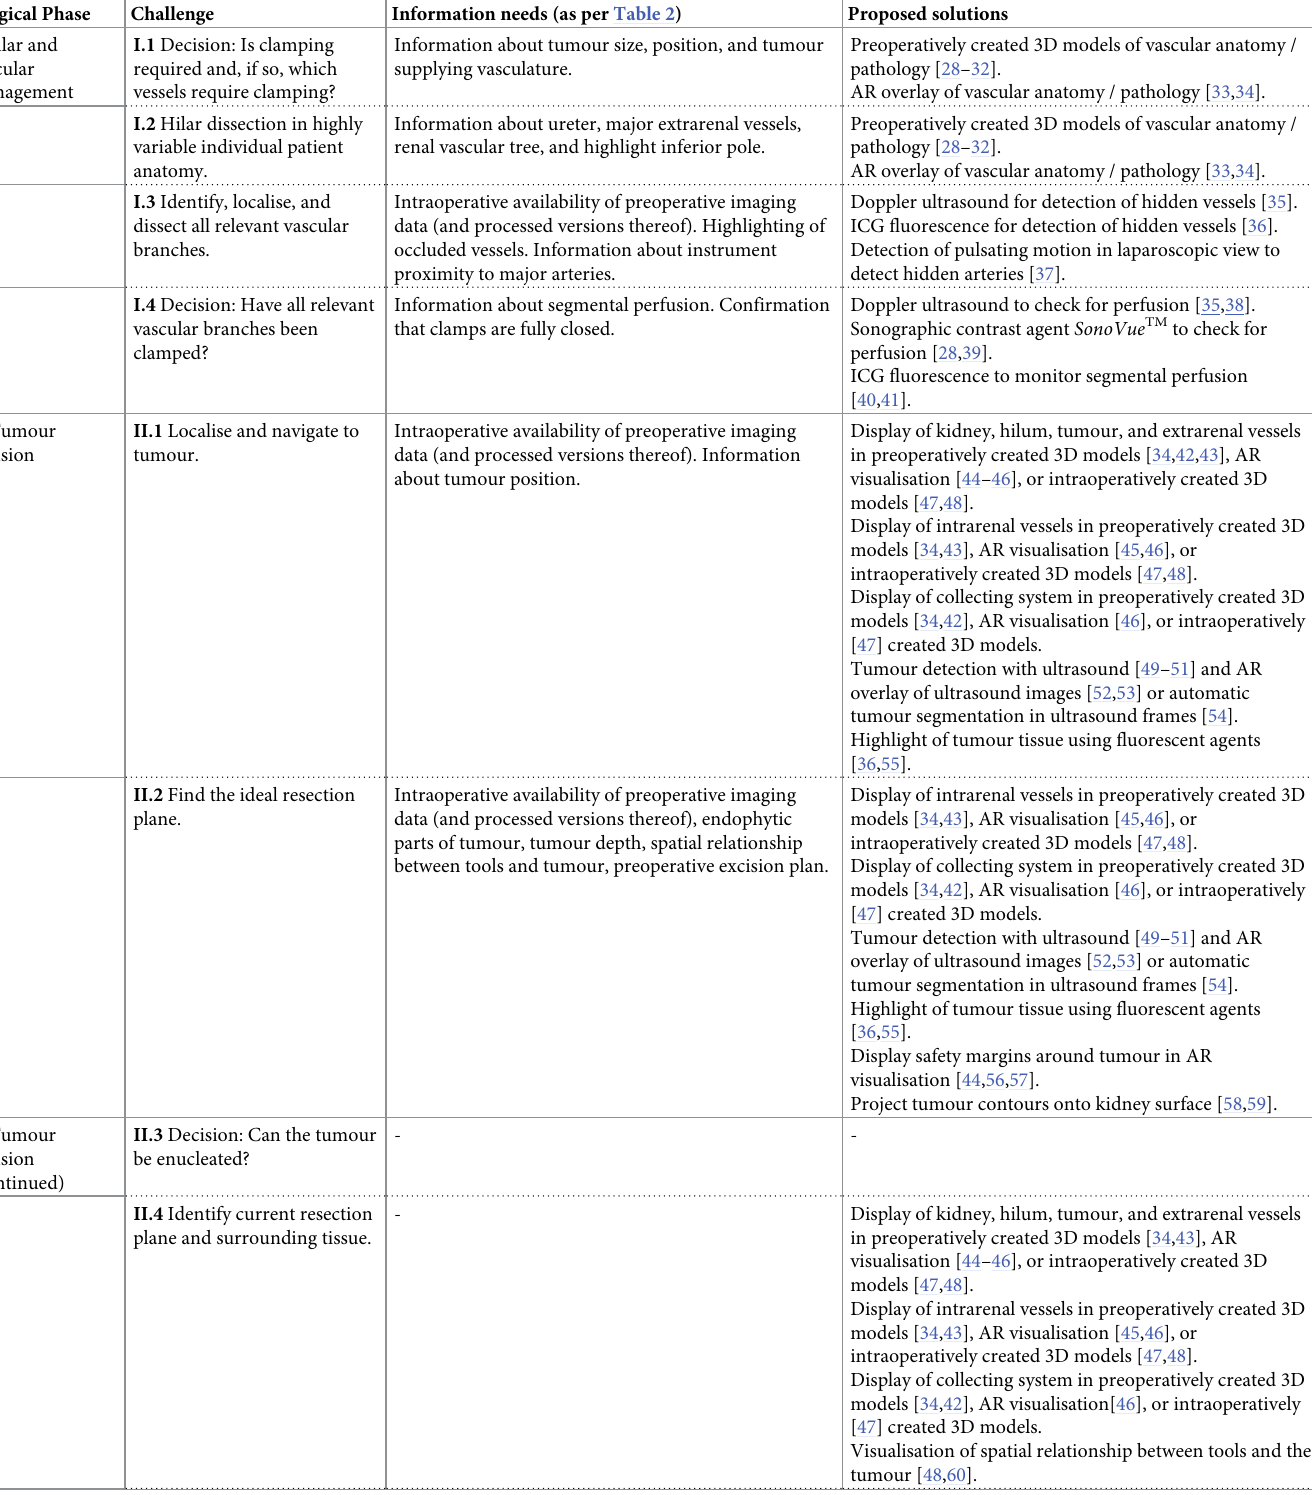
Table 3. Surgical challenges and information needs identified in the interview study and existing software assistance solutions. Surgical